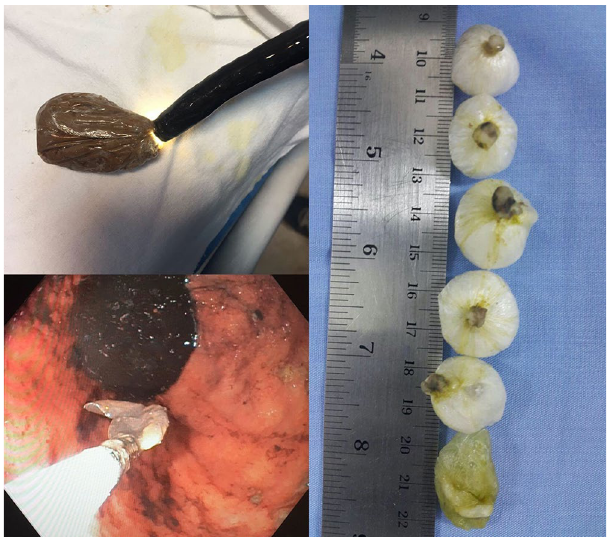
Figure 1. Lower left: Retrieved baggie by endoscope basket inside the stomach; upper left: Retrieved heroin baggie outside of the body after retieval; right: samples of methamphetamine baggies retrieved through endoscopy, the bottom baggie had opened in the stomach (prior to